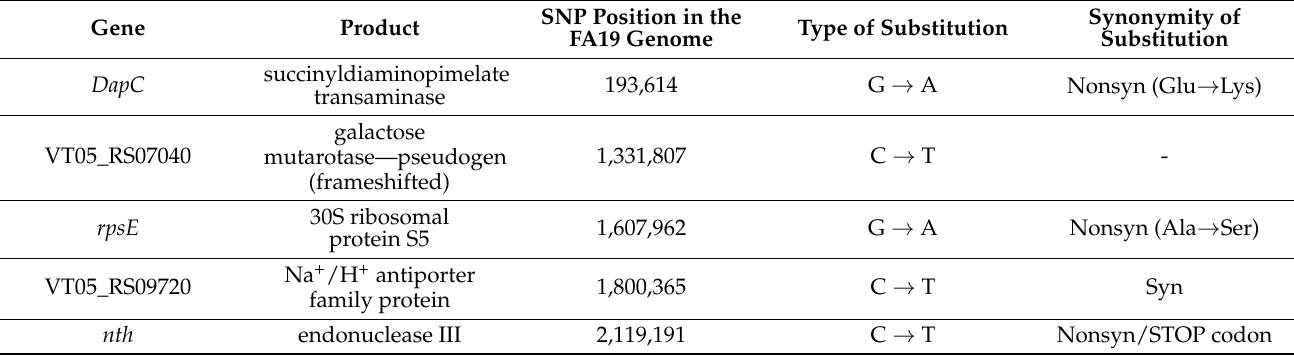
Table 3. Five unique SNPs discriminating between N. gonorrhoeae clades with typical and atypical biochemical